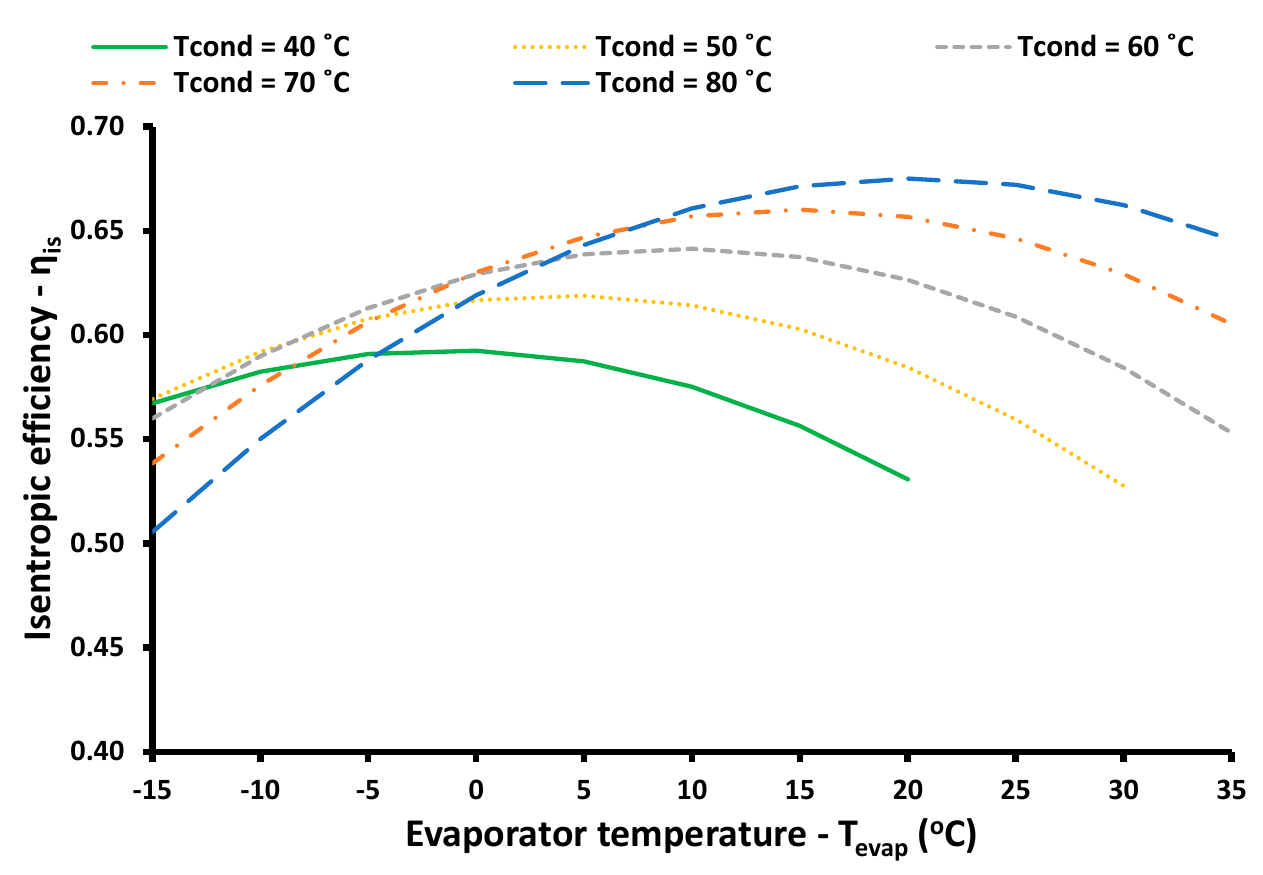
Figure 4. Comparison of the calculated COP with the developed model of the COP by Bitzer.